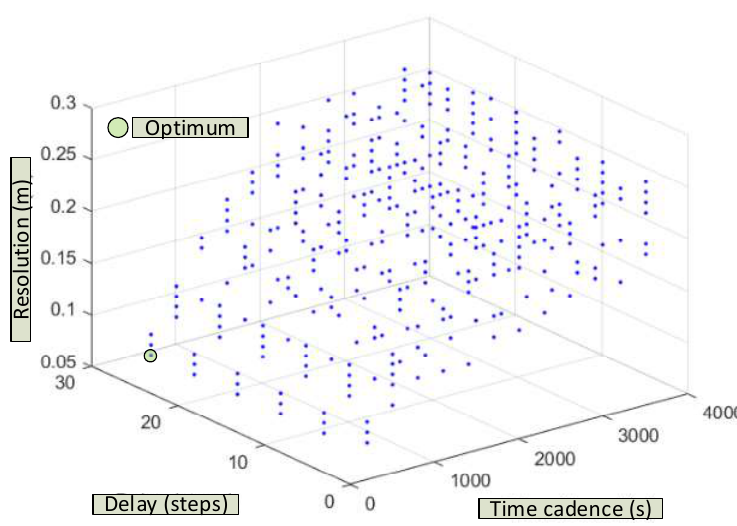
Figure 13. Resolution of the dynamic NARNN as a function of the selected cadence and the lag (or delay) used in the NARNN feedback.